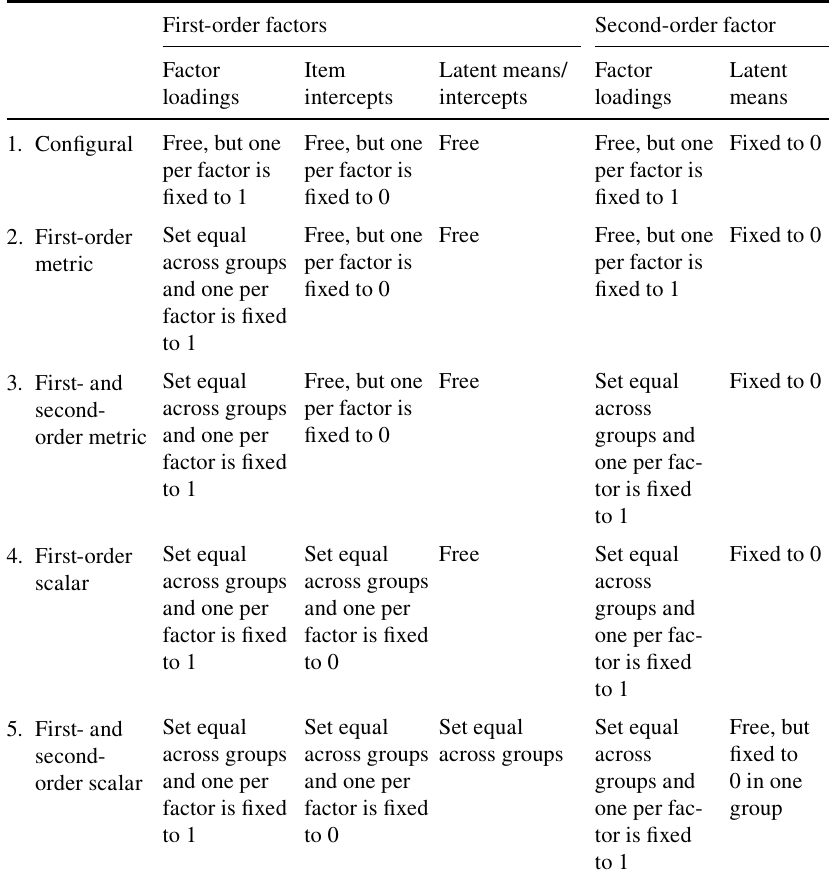
Testing for Measurement Invariance and Possible Parameter Con- straints in Multiple Group Confirmatory Factor Analysis with